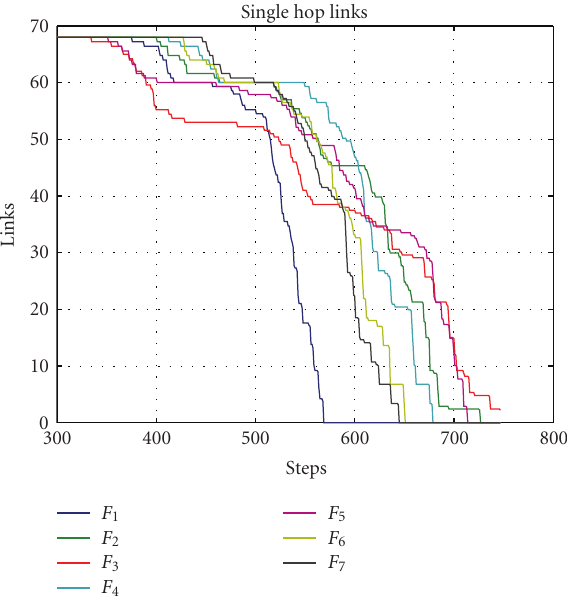
Figure 9: Percentage of alive nodes during iterations for di ff erent criteria, defined in Table 2 (average results over 10 trials).